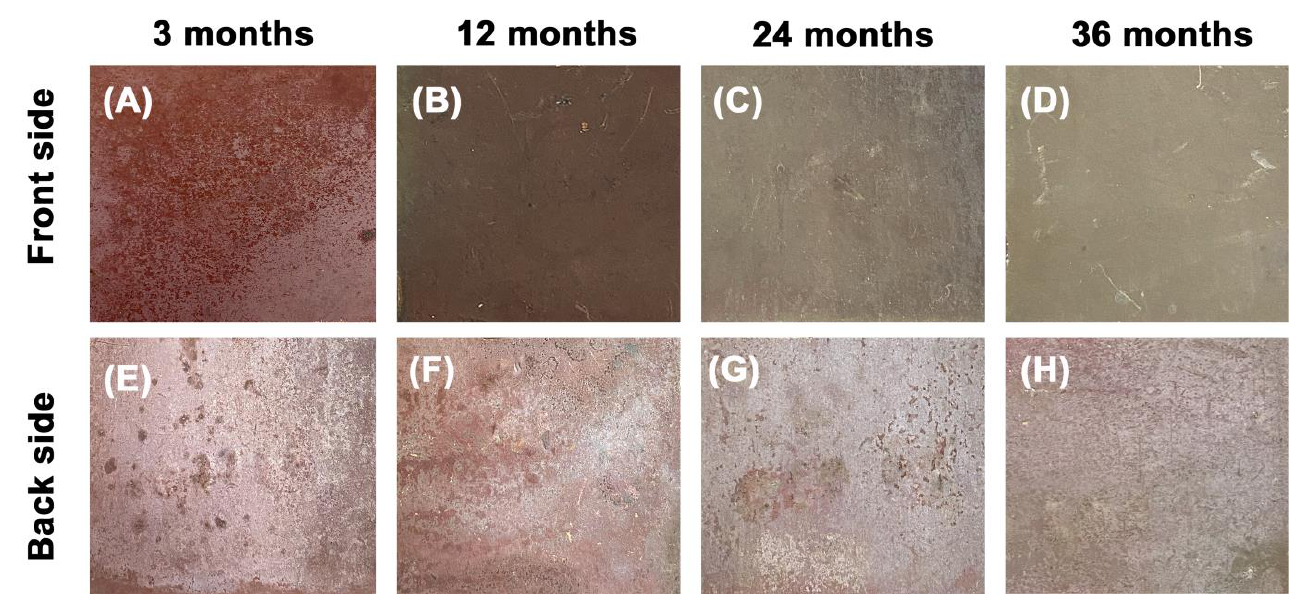
Figure 7. Surface appearance of the patina of copper exposed in Rapa Nui for different periods. 3 months ( A, E ), 12 months ( B, F ), 24 months ( C, G ), and 36 months ( D, H ).